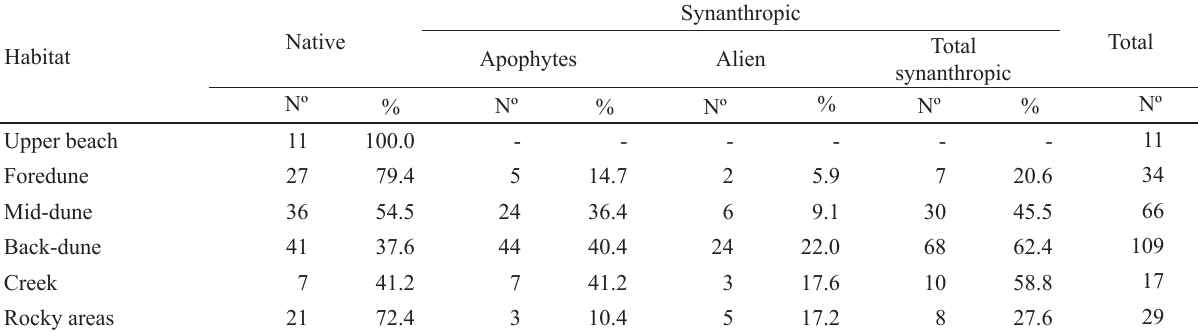
Table 6. Synanthropisation of habitats . Native Habitat